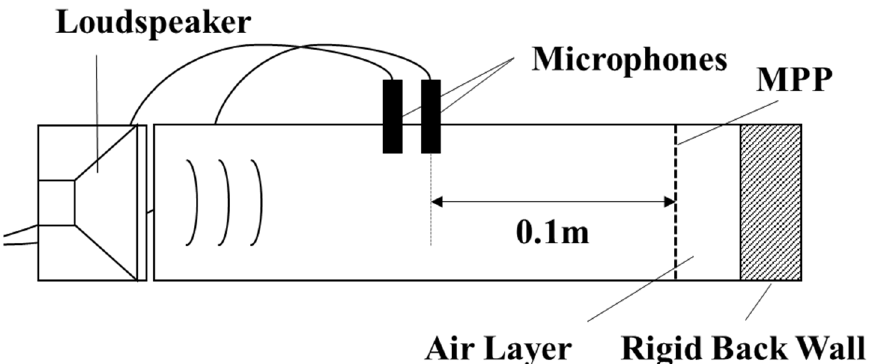
Figure 6. A diagram of the measurement equipment. The distance between the two microphones was 50 mm.